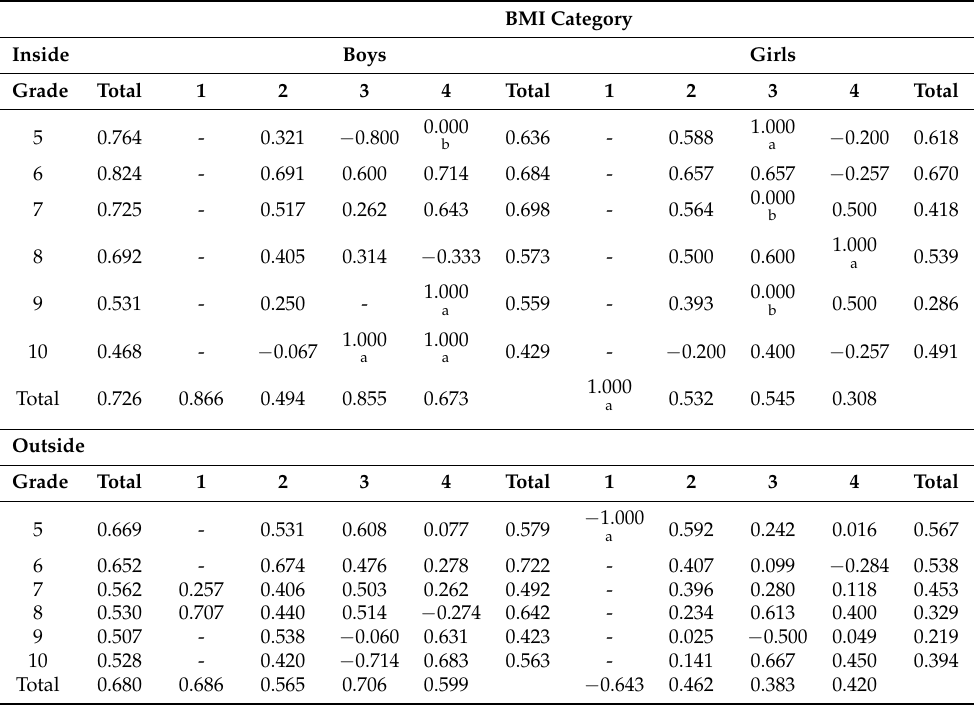
Table 7. The correlation between 1985 and 2012 PA ranking (BMI: 1 = Underweight, 2 = Normal weight, 3 = Overweight, 4 =